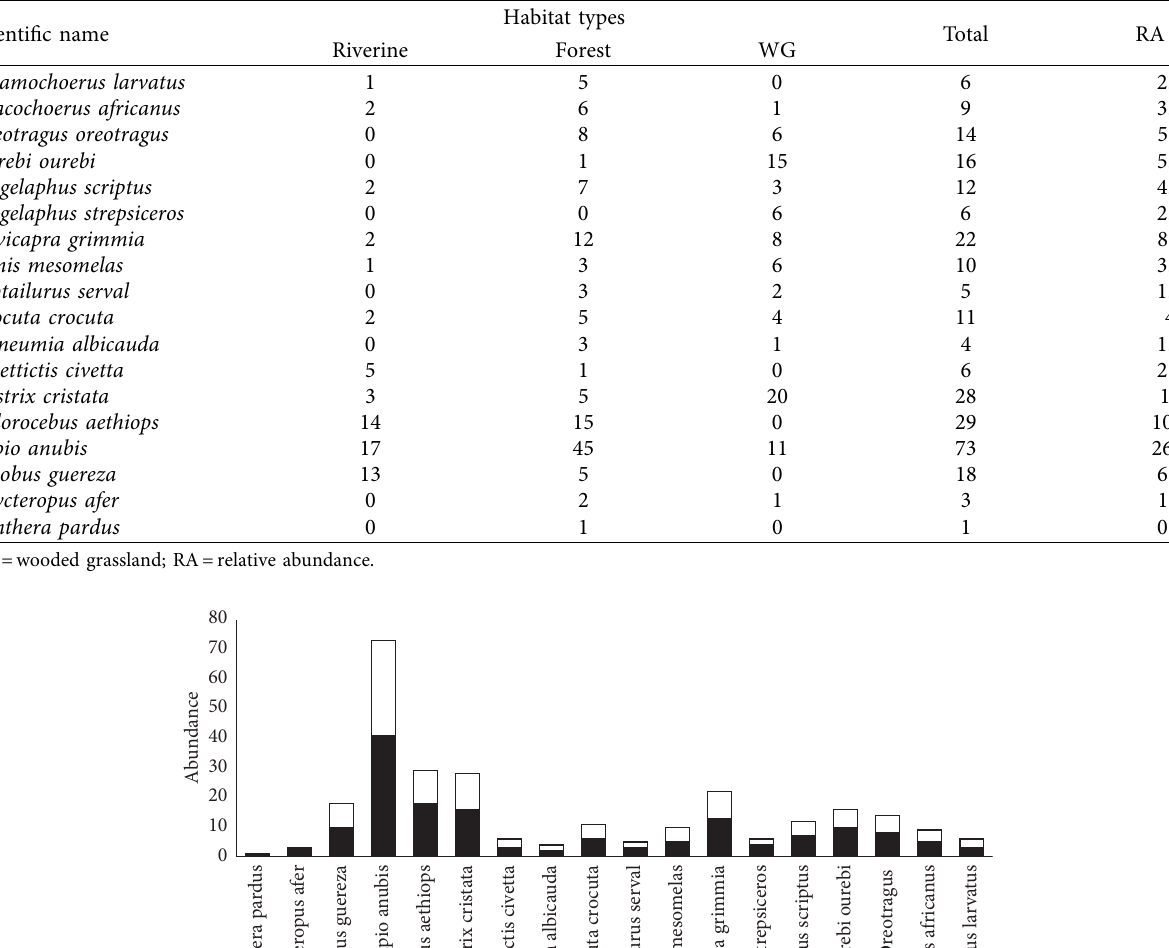
Table 3: Habitat association and relative abundance of mammal species among habitats.